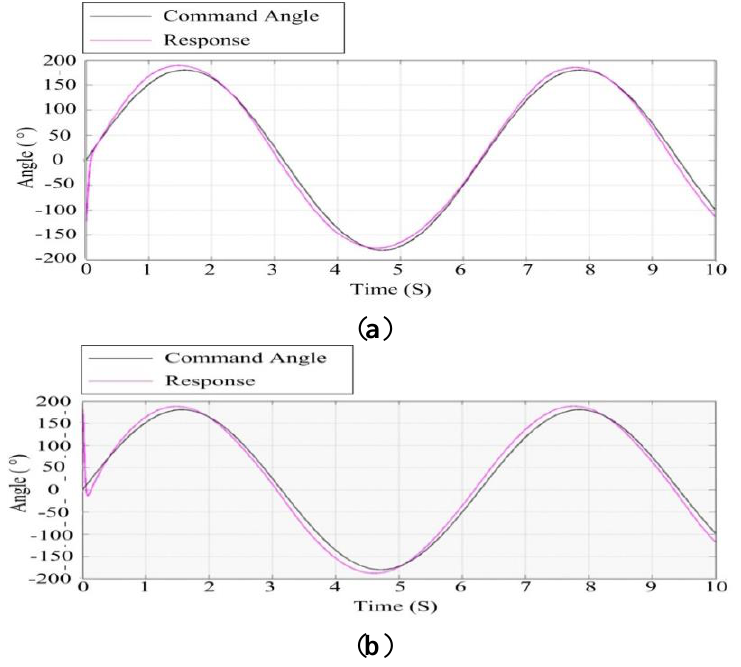
Figure 14. The response curve to a sinusoidal angular command in the electromechanical co-simulation model: ( a ) the azimuth gimbal; ( b ) the pitch